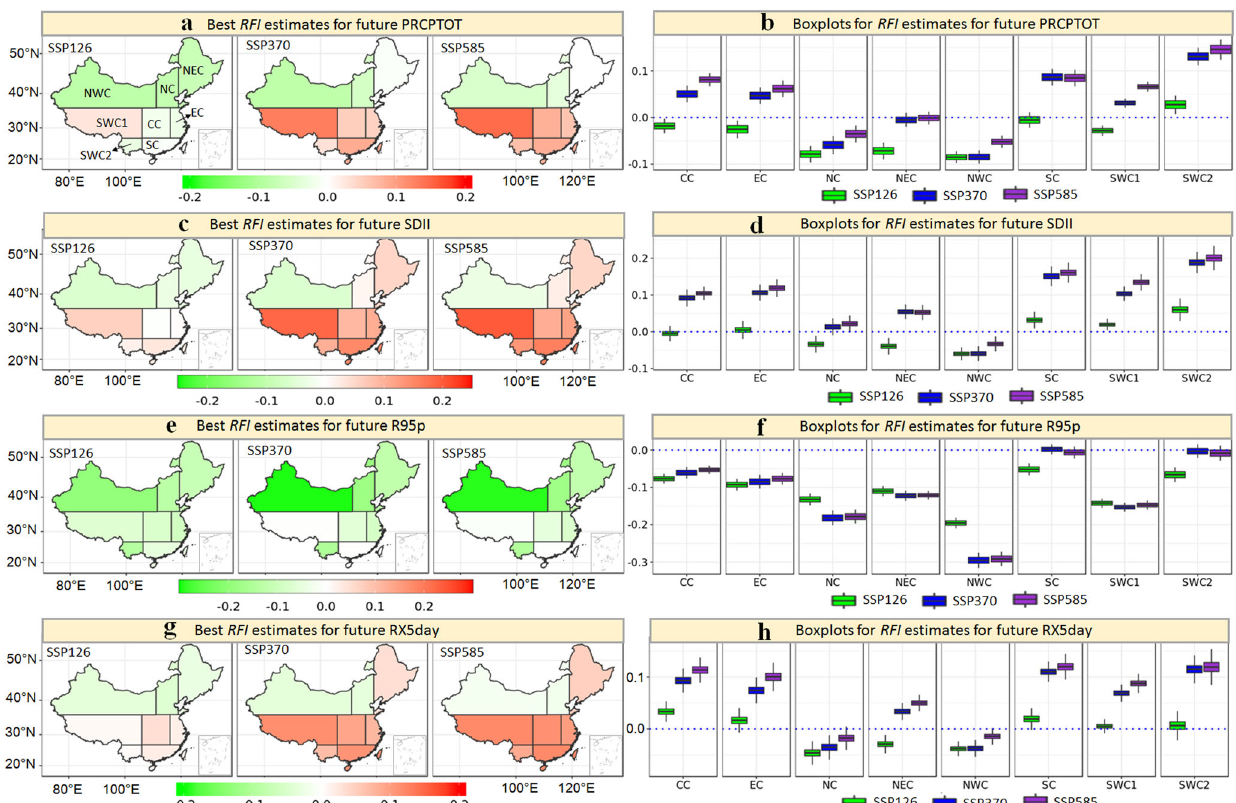
Fig. 7 Maps of the best temporal RFI estimates. The best temporal RFI estimates were calculated based on the bootstrapping procedure for a PRCPTOT, c SDII, e R95p, and g RX5day over eight regions in China. b , d , f , h The uncertainty range (5th to 95th percentile) of RFI and the horizontal line in the box represents the best estimate (i.e., median value). The sub fi gures were done in the software R 4.0.2 (https://cran.r- project.org/bin/windows/) and then the sub fi gures were merged by using the Microsoft PowerPoint 2013 software (https://www.microsoft.